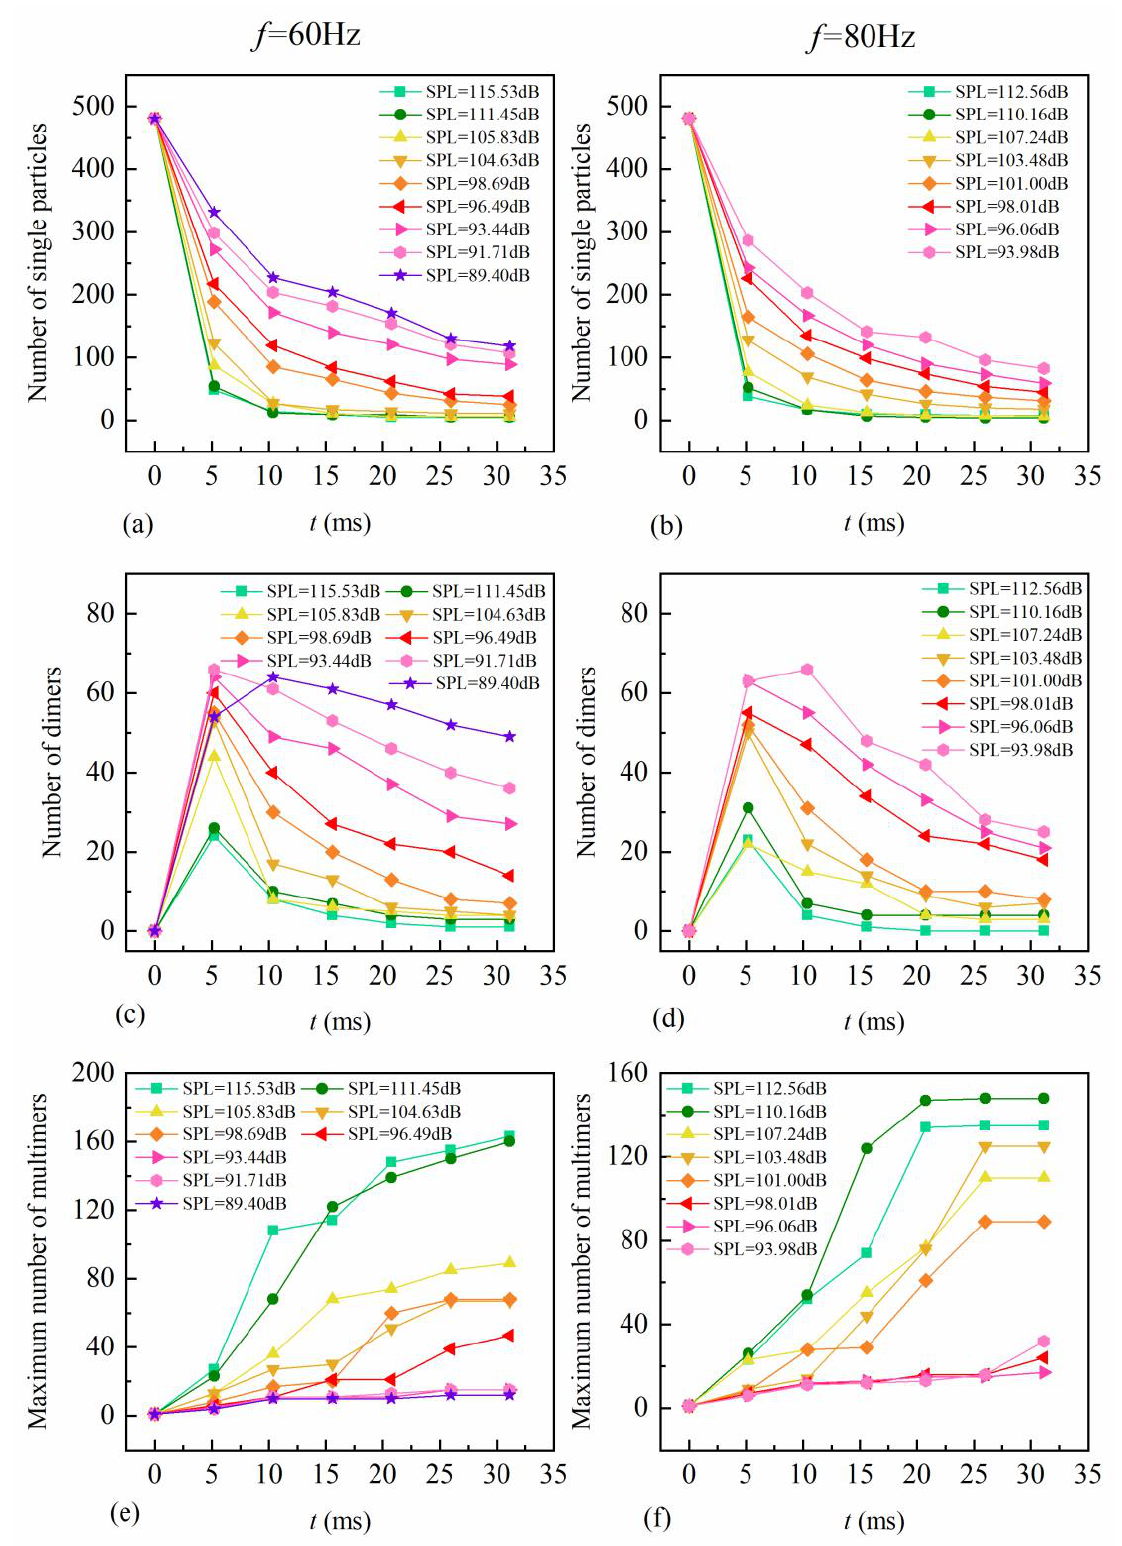
Figure 11. Plots of ( a ) the number of single particles for 60 Hz sound waves, ( b ) the number of single particles for 80 Hz sound waves, ( c ) the number of dimers for 60 Hz sound waves, ( d ) the number of dimers for 80 Hz sound waves, ( e ) the maximum number of particles in the multimers for 60 Hz sound waves, and ( f ) the maximum number of particles in the multimers for 80 Hz sound waves.